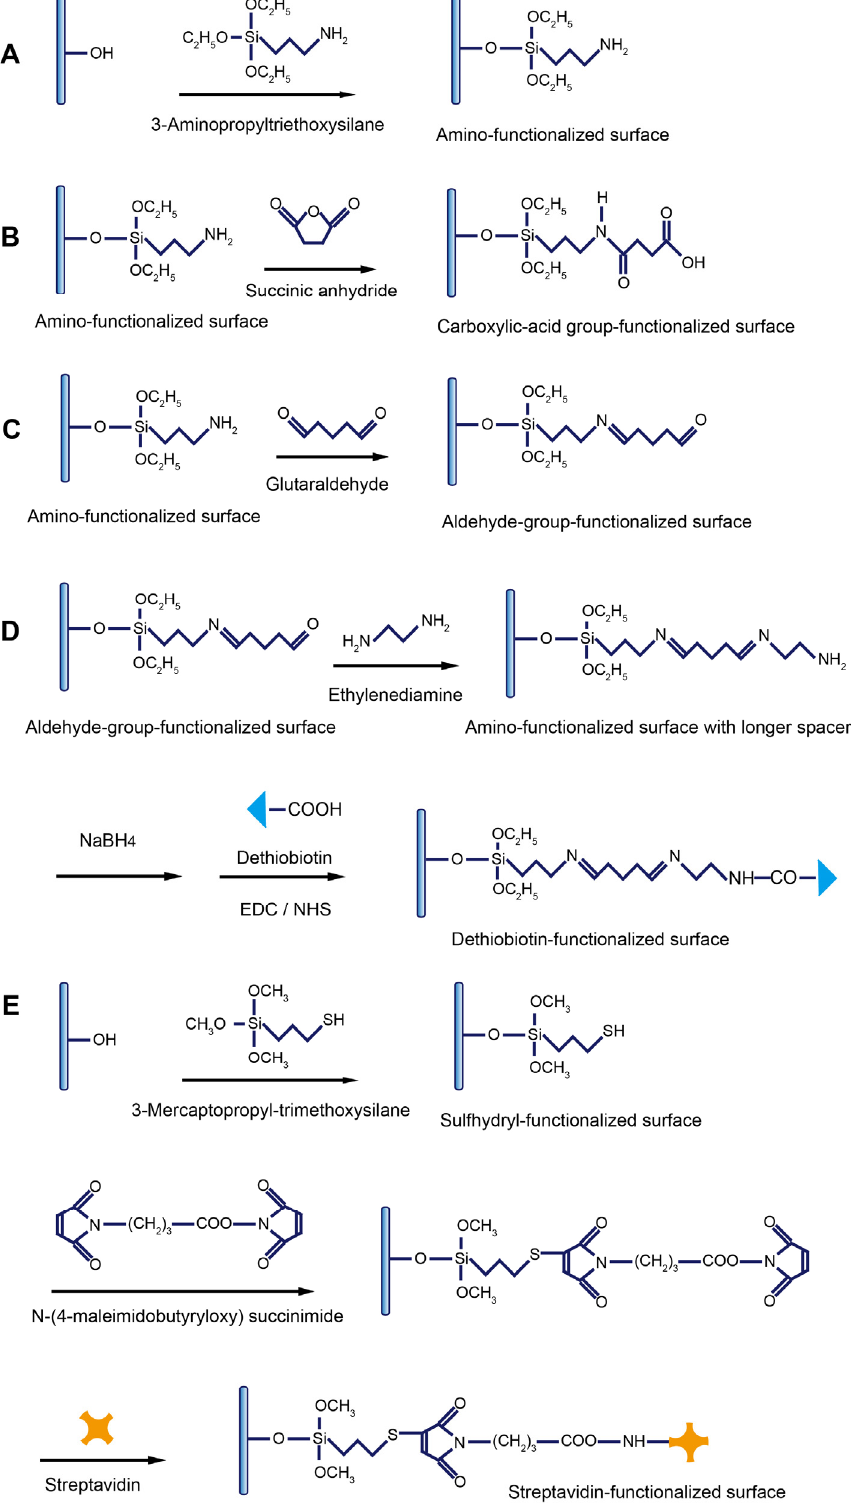
Figure 5. The representative methods to modify the fiber with active functional groups: ( A ) amino-group-functionalized surface; ( B ) carboxylic-acid-group-functionalized surface; ( C ) aldehyde-group-functionalized surface; ( D ) dethiobiotin-group-functionalized surface; and ( E ) sulfhydryl, NHS ester, or streptavidin-group-functionalized surface. EDC: 1-ethyl-3-(3-dimethylaminopropyl)carbodiimide; NHS: N-hydroxysuccinimide.